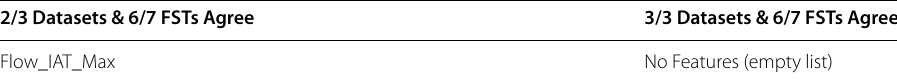
Table 8 2 Feature Popularity Lists where 7/7 FSTs Agree ( fst A 2/3 Datasets & 7/7 FSTs Agree 3/3 Datasets & 7/7 FSTs Agree No Features (empty